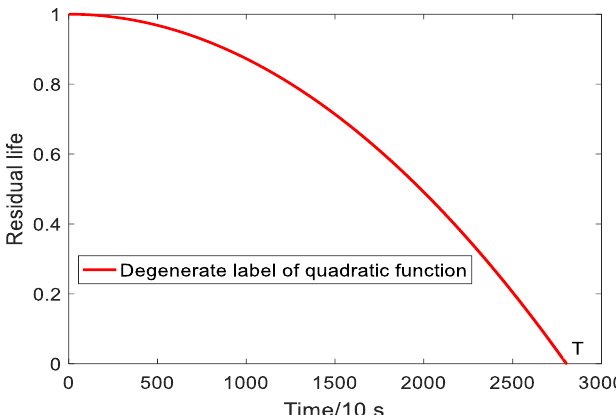
Figure 9. Quadratic function label.